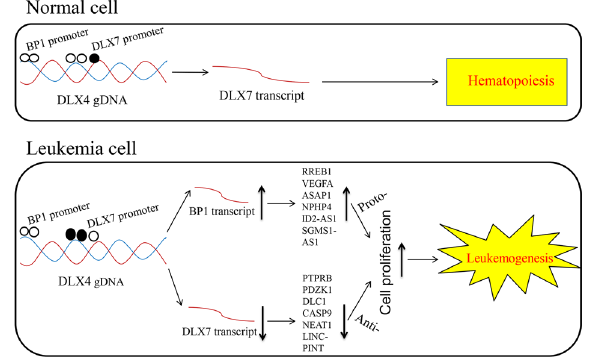
Fig. 5 Schematic diagram of DLX4 gene isoforms in promoting